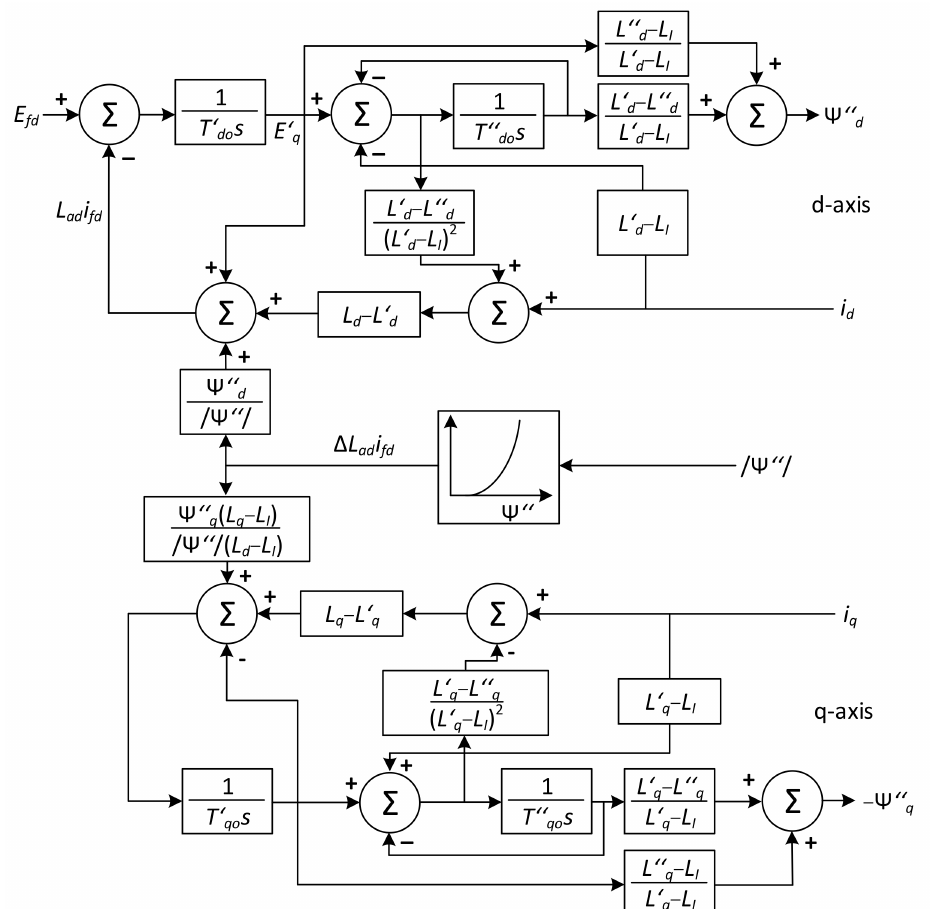
Figure 5. Structure of the electromagnetic model of a blurred